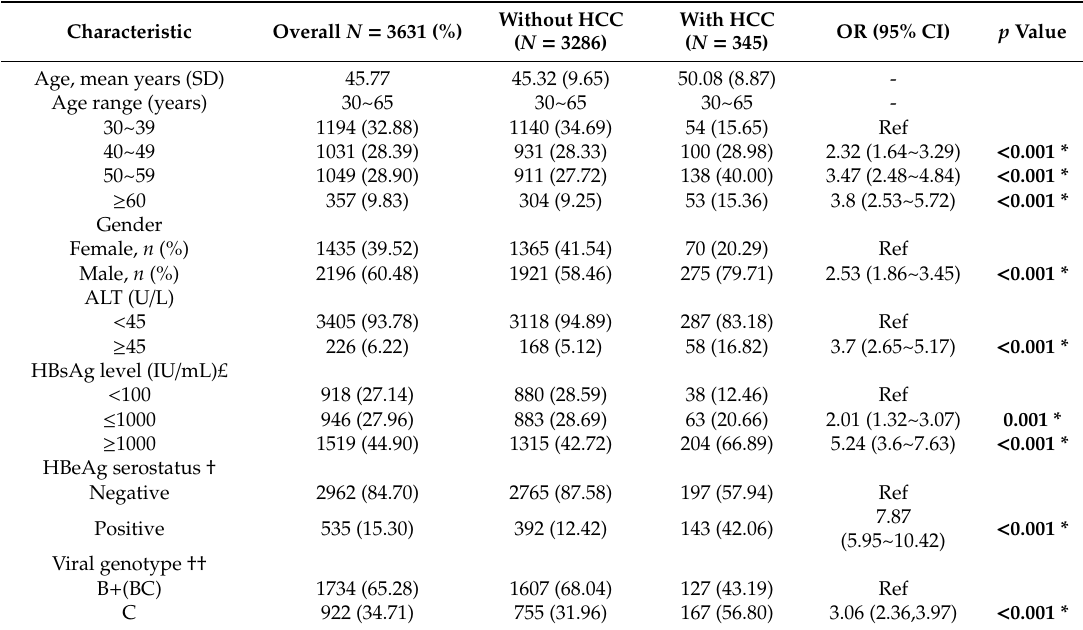
Table 1. Baseline characteristics and multivariate adjusted odd ratios (ORs) of hepatocellular carcinoma (HCC) according to various risk factors.